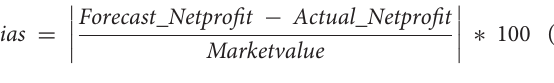
forecast from the actual value as a measure of the forecast accuracy and use it as a sensitivity measure of the dependent variable. The specific calculation formula is as